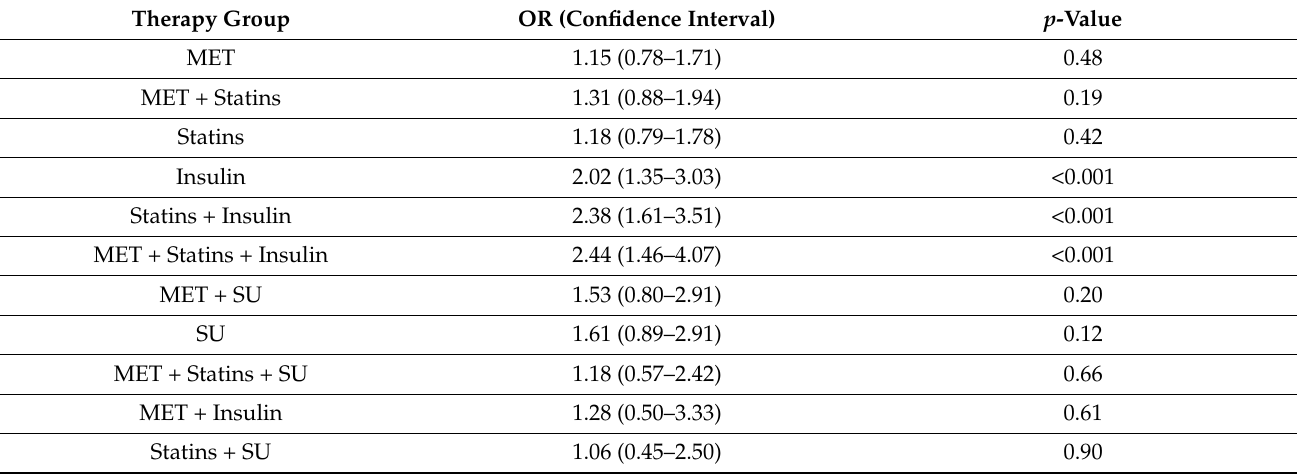
Table 2. Sex-specific regression results for models with male patients only. MET = metformin, SU = sulfonylureas. Therapy